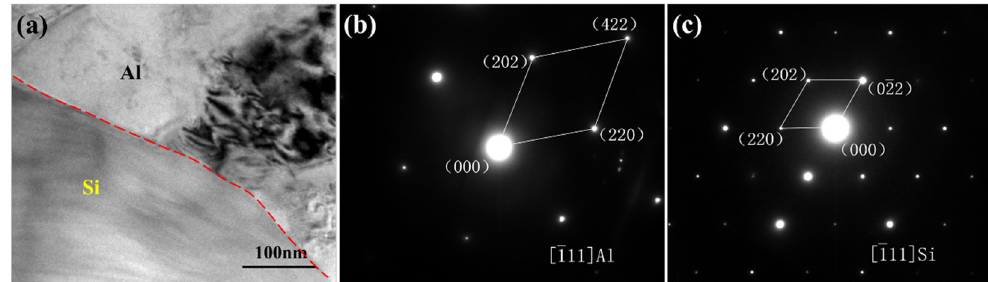
Figure 4. TEM observation of SiCp/Al-Si composites without CeO 2 : ( a ) Al-Si interface; ( b ) Diffraction patterns of the Al matrix; ( c ) Diffraction patterns of the precipitated Si.